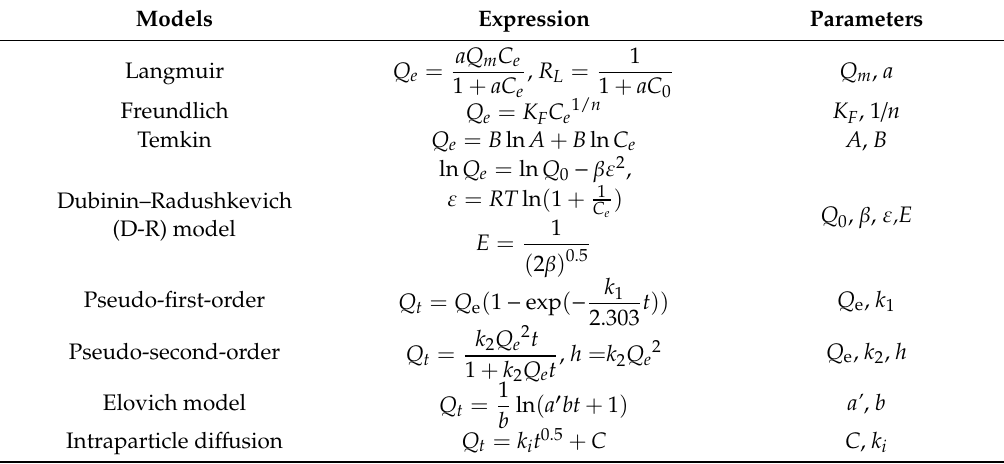
Table 1. List of isotherms and kinetics